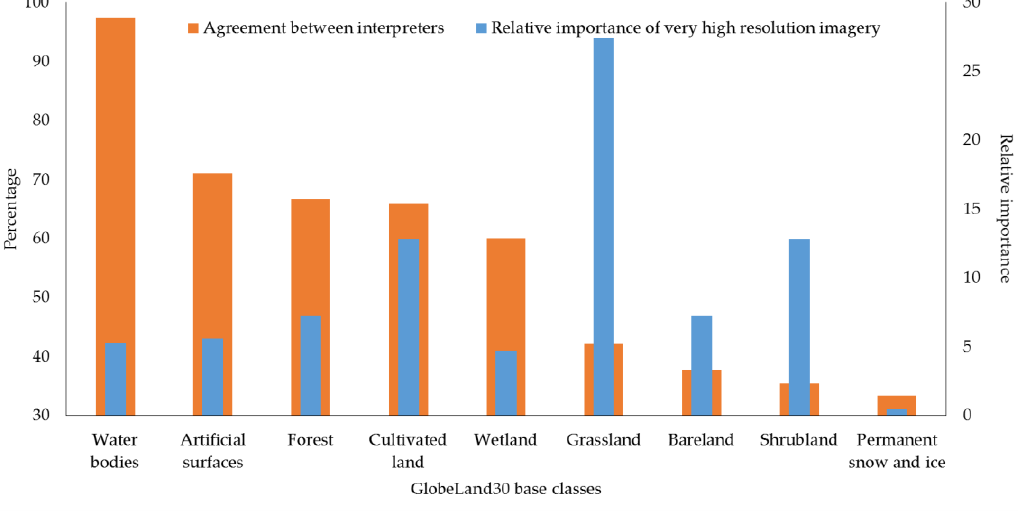
Figure 10. The agreement of interpreters and the relative importance of very high resolution imagery by class in GlobeLand30.